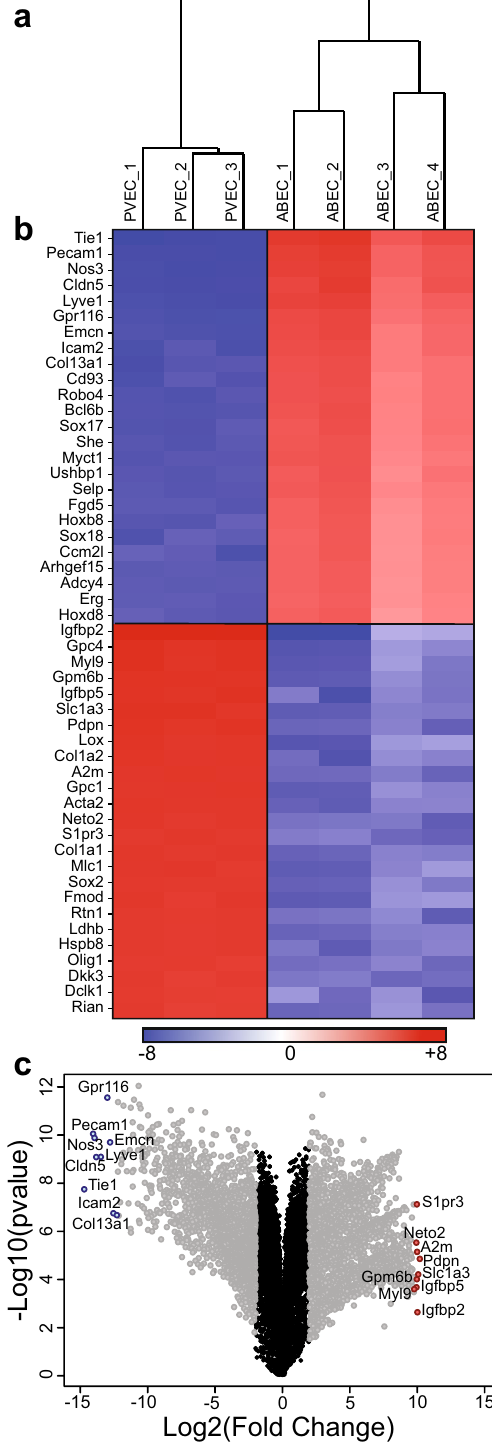
Figure 1. Baseline expression profile of PVEC and ABEC highlights the distinct identity of these vascular beds. ( a ) Hierarchical clustering indicates total segregation between PVEC and ABEC. ( b ) Heatmap of the top 50 genes that were significantly different in PVEC vs. ABEC, based on fold change. Red indicates genes with higher expression and blue indicates genes with lower expression in PVEC vs. ABEC. ( c ) Volcano plot encompassing all analyzed genes, depicted as dots. Black dots represent genes that were not significantly different, while gray dots represent genes that were significantly different in PVEC vs. ABEC, based on fold change (FC) > 2 and p-value < 0.05. Highlighted in blue dots are the genes that were most significantly lower, and in red dots genes that were most significantly higher in PVEC vs.